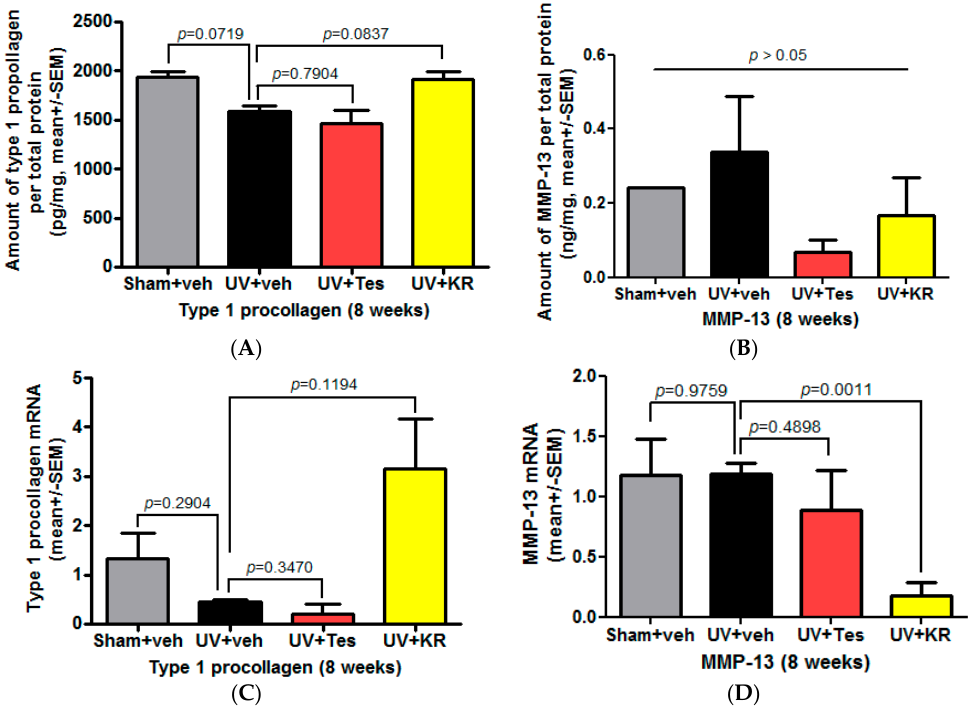
Figure 5. Effect of a mixture of extracts of Kochia scoparia and Rosa multiflora (KR) on dermal expression of procollagen and collagenase in photoaging murine skin. The expression of collagen and collagenase in photoaging skin, represented by procollagen type 1 and matrix metalloproteinase (MMP)-13, was determined by ELISA after topical application of KR, vehicle (veh), or tesaglitazar (Tes) for 8 weeks. In photoaging skin, the expression of type 1 procollagen protein ( A ) and mRNA ( C ) levels decreased; this decrease was not significant. KR increased these levels while Tes did not ( A , C ). On the other hand, expression of MMP-13 did not change ( B , D ). However, KR, but not Tes, significantly decreased the expression of MMP-13 mRNA ( D ).